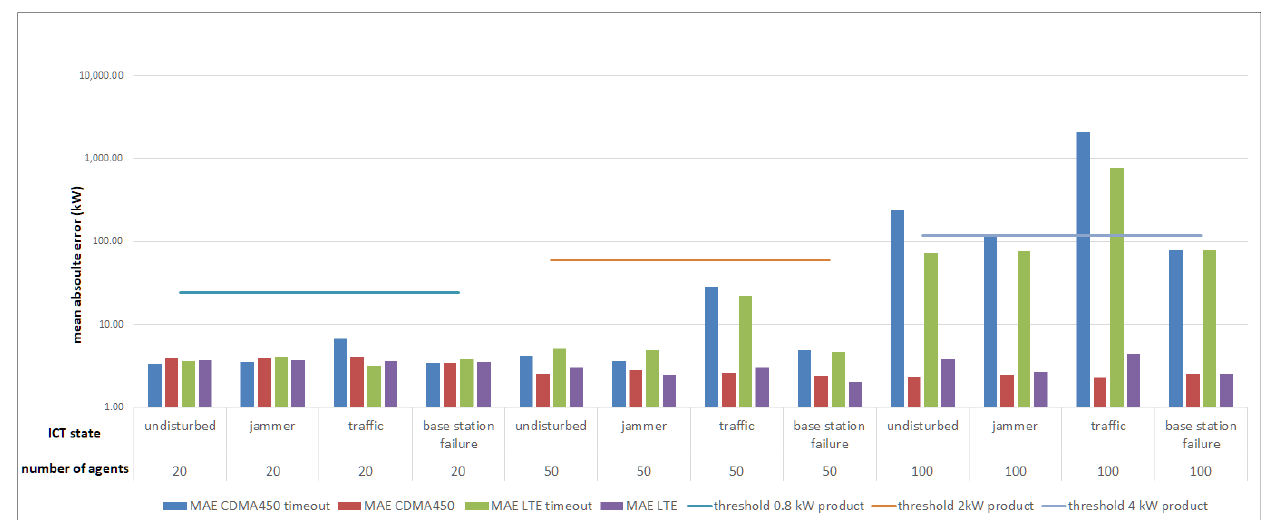
Figure 10. Mean deviation of the solution to the target schedule for both communication technologies with and without negotiation time-out. From left to right: the scaled numbers of agents in the VPP for the different ICT-scenarios. The accepted deviation from the respective products serve as thresholds.